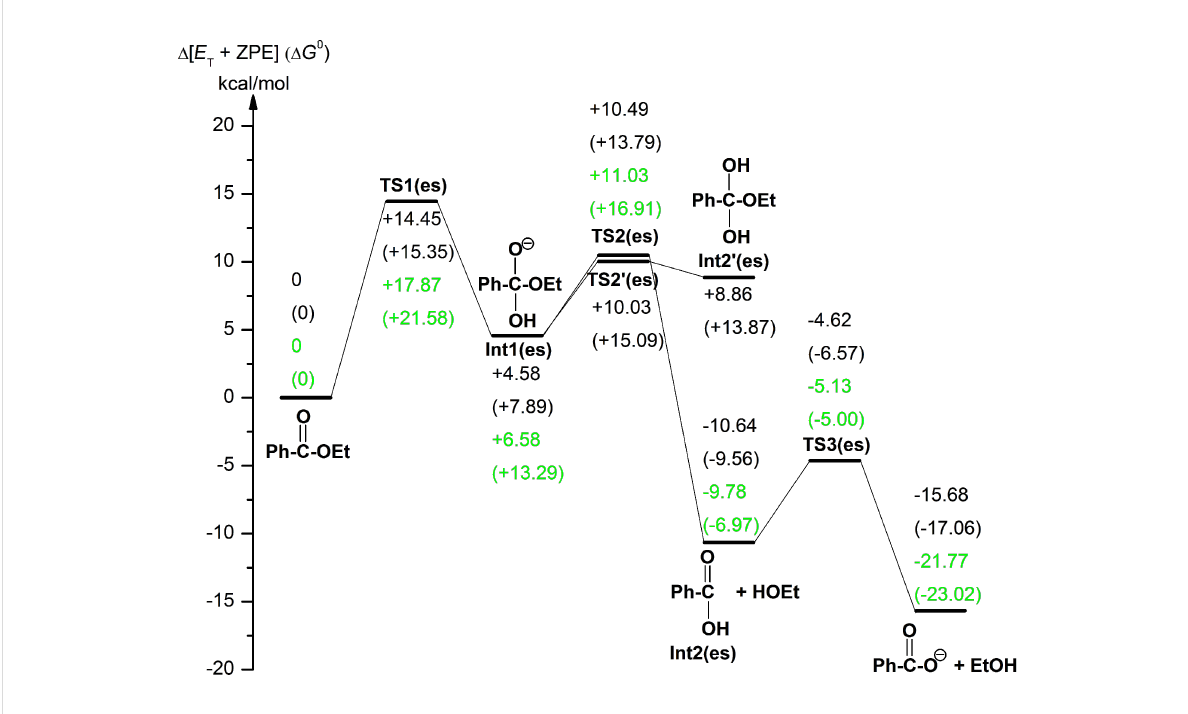
Figure 6: Changes of B3LYP/6-311++G(d,p) SCRF = PCM//B3LYP/6-31(+)G(d) Et + ZPE and (Gibbs free energies) of the ester hydrolysis in Figure 4 and Figure S3 (Supporting Information File 1). Energies given in green are for the Na + -containing reaction in Figure S3.